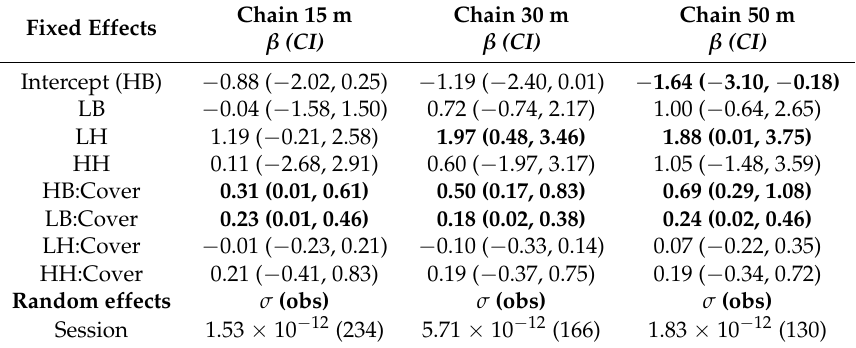
Figure 6. Relationship between logged distance to cover (m) on logged group size (n) as a function of human disturbance at each definition of chain rule (15 m, 30 m, and 50 m). Linear trend lines were plotted for significant relationships. Table 2. Results of GLMMs testing for effect of disturbance (High Benign, Low Benign, High Harm, High Harm) and logged distance to cover on log-transformed group size. Each model considers the data using a different chain-rule (15 m, 30 m, or 50 m) using negative binomial errors. Effects ( β ) are presented with 95% confidence intervals (method: Wald) which are highlighted in bold when intervals do not cover zero. Categorical fixed effects are relative to reference level (High